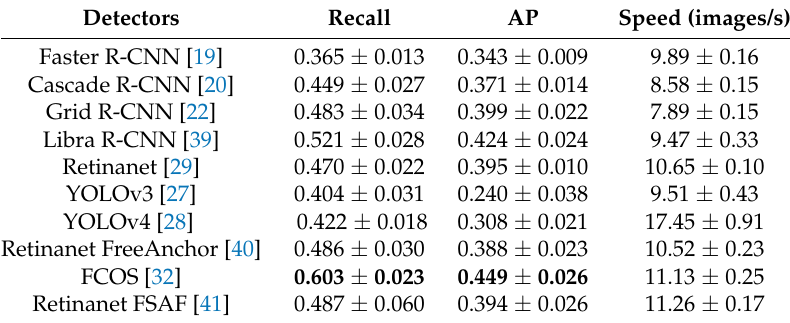
Table 10. Results on the EPD-C subset. Train resolution, 1 m/pixel; test resolution, 4 m/pixel. AP refers to average precision. Recall, AP, and speed are expressed in the format of mean ± standard deviation on the basis of 10 rounds of test